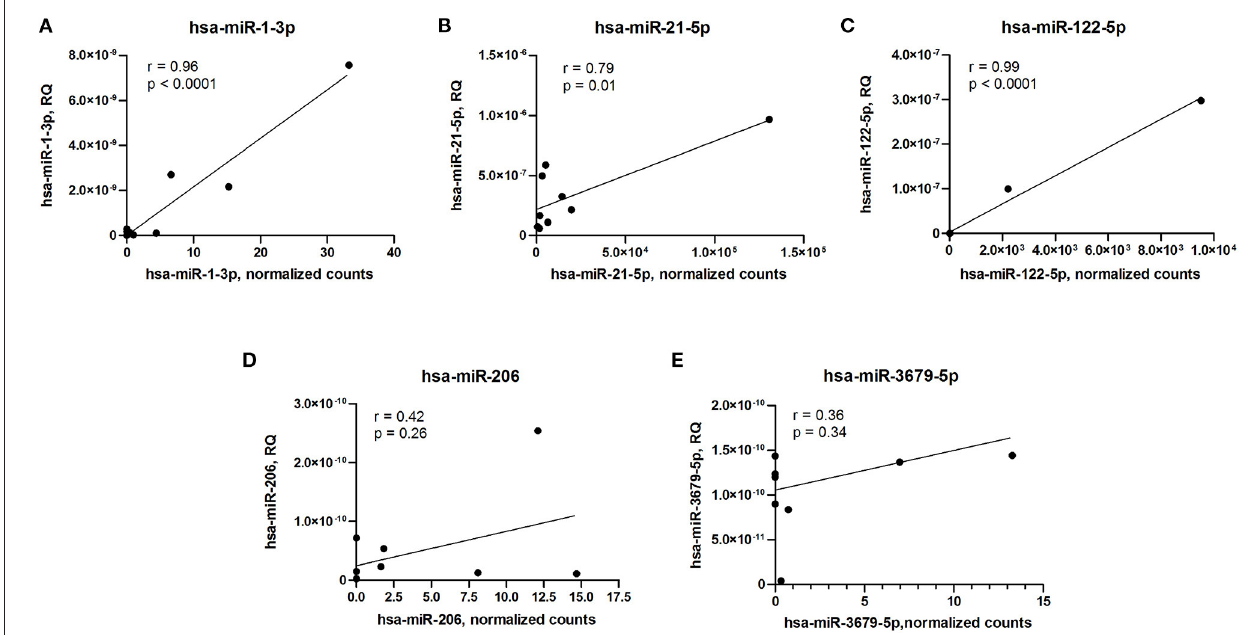
FIGURE 3 | Correlation analyses of microRNA expression between qPCR and small RNA sequencing data. (A) hsa-miR-1-3p. (B) hsa-miR-21-5p. (C) hsa-miR-122-5p. (D) hsa-miR-206. (E) hsa-miR-3679-5p. RQ, relative quantity. Pearson’s correlation coefficient (r) and p -value are indicated in each